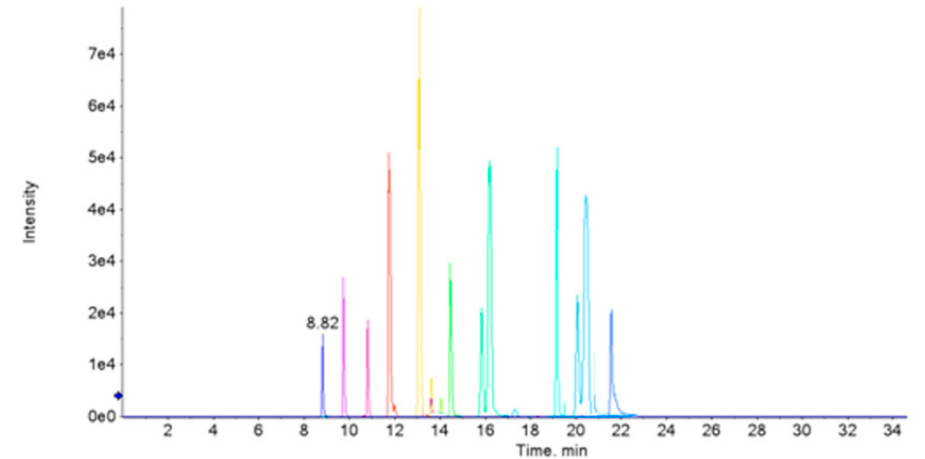
Figure 10. The typical XICs of the HPLC-MS/MS MRM mode analysis in potential biomarkers. Table 1. LC-MS/MS data of the discriminant metabolites related to NP exposure and their identification results.